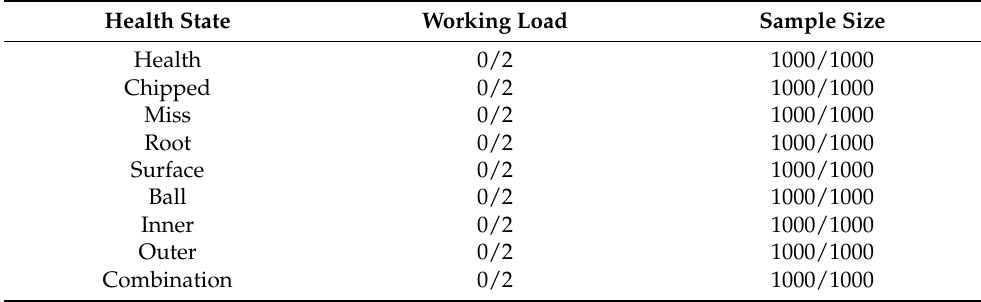
Table 2. Detailed description of SEU